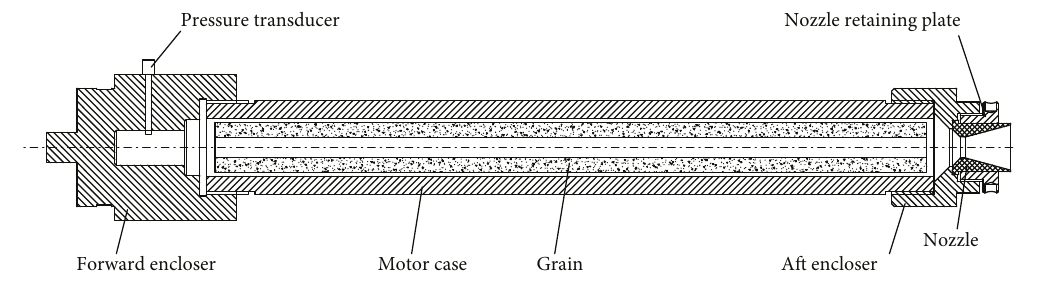
Figure 3: Schema of the test motor. Table 1: Geometry parameters of the test motor.